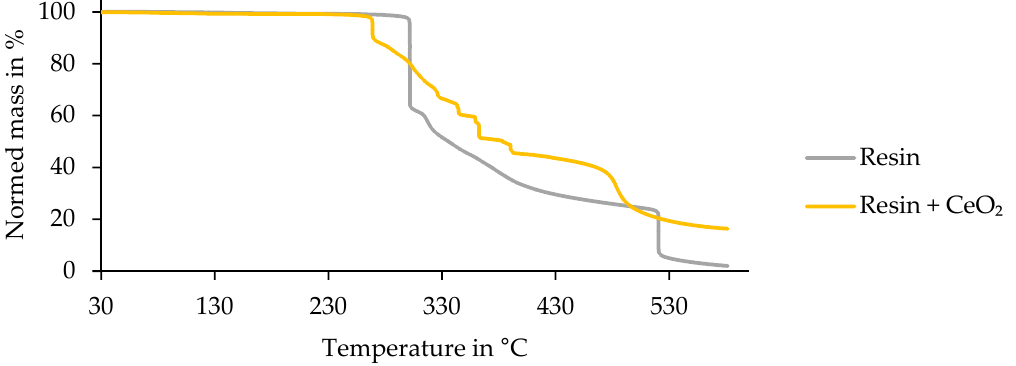
Figure 10. Thermogravimetric analysis of pure epoxy resin and pure epoxy resin and epoxy resin combined with the semiconductor CeO 2 .